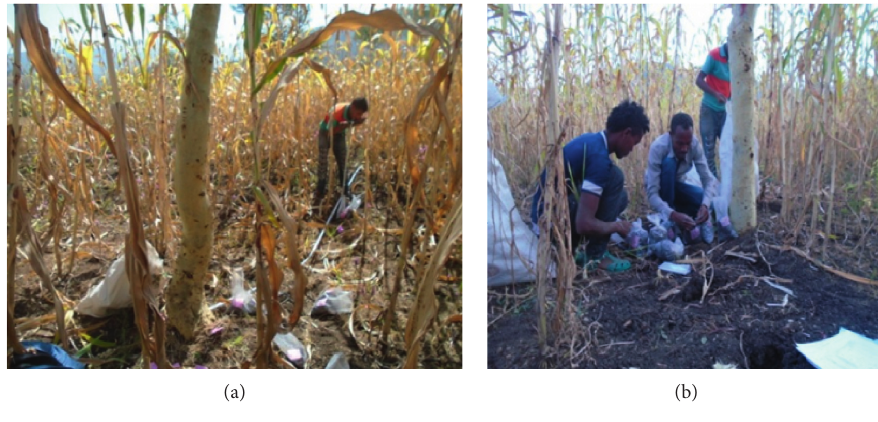
Figure 3: Soil sampling under tree